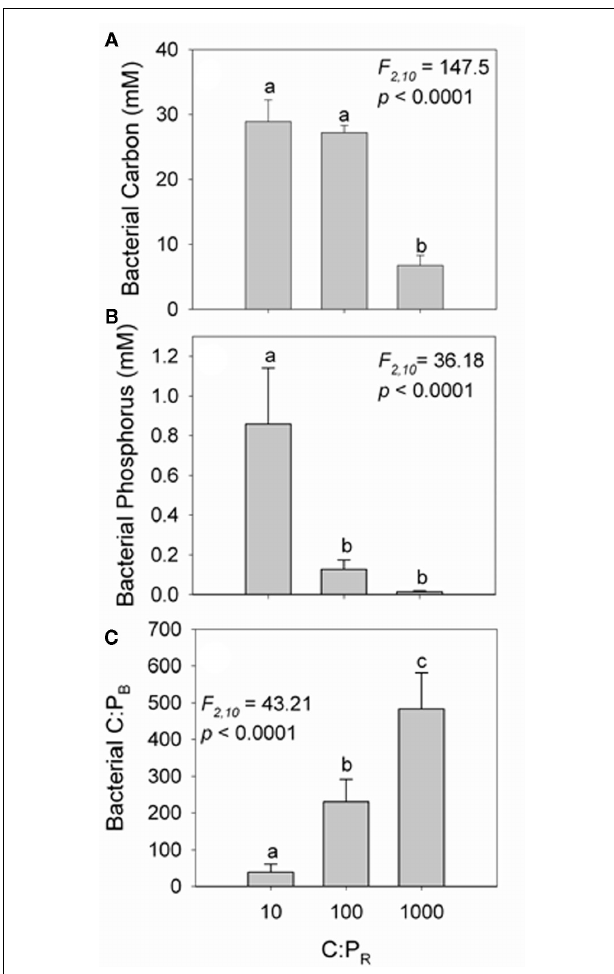
FIGURE 2 | Results of replicated chemostat experiment using Arthrobacter sp. Panels show the effect of three distinct levels of resource C:P on (A) Arthrobacter sp. culture biomass as millimolar particulate C, (B) Arthrobacter sp. biomass phosphorus as millimolar particulate P, and (C) Arthrobacter sp. C:P B (molar ratio).